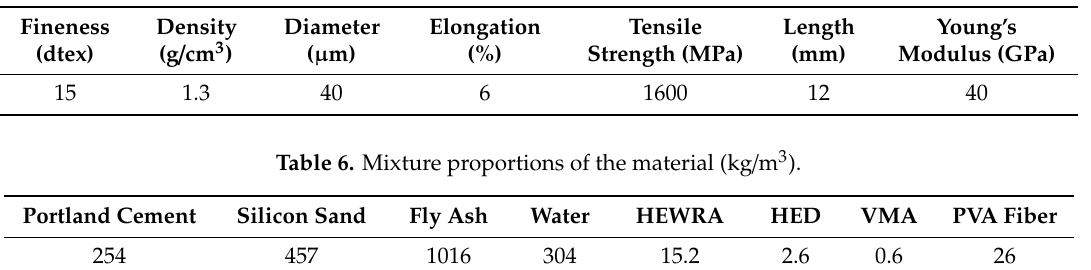
Table 5. Physical properties of polyvinyl alcohol (PVA) fiber.